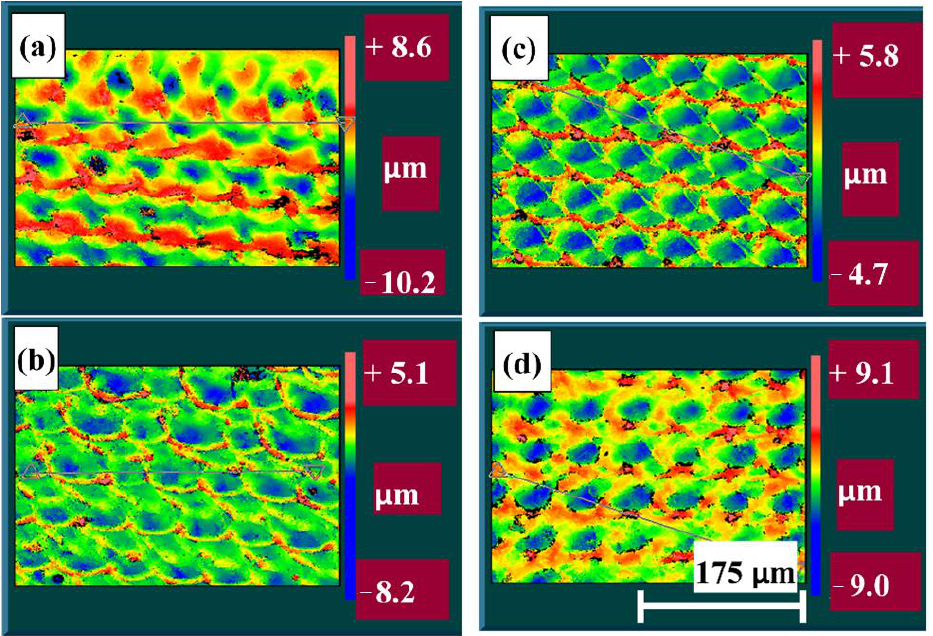
Figure 5. Pseudo-color image of 3D profiles from the profilometer: ( a ) AlTiN1; ( b ) AlTiN2; ( c ) AlTiN3 and ( d ) AlTiN4. Table 6. Area surface roughness parameters after stripping of AlTiN